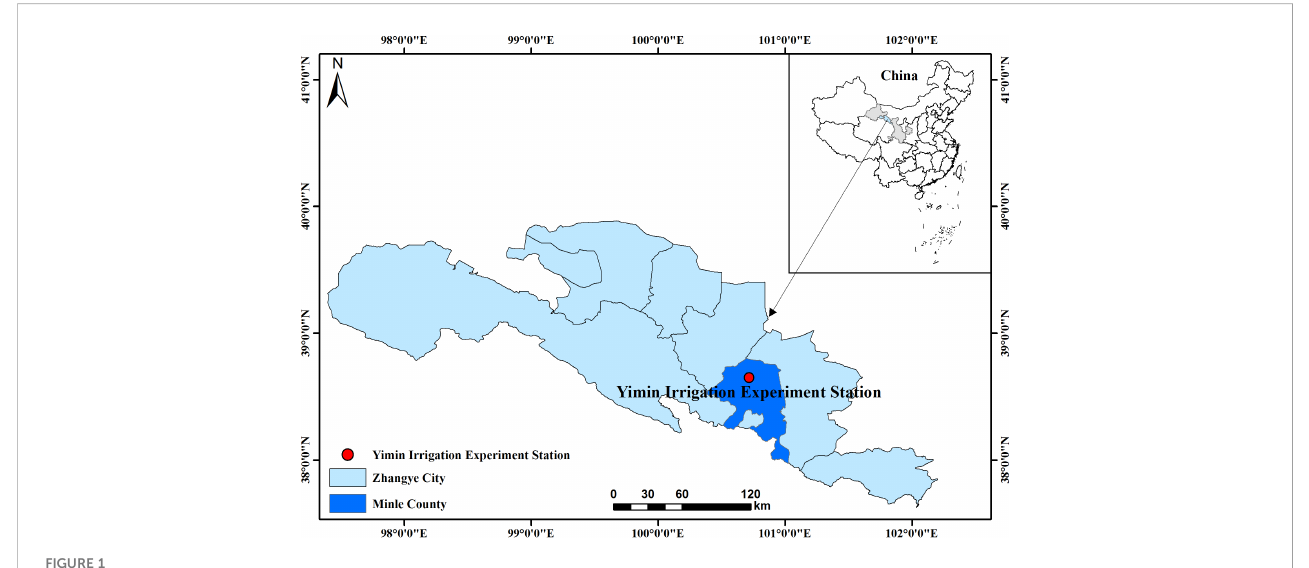
FIGURE 1 Location of experimental site (Minle,